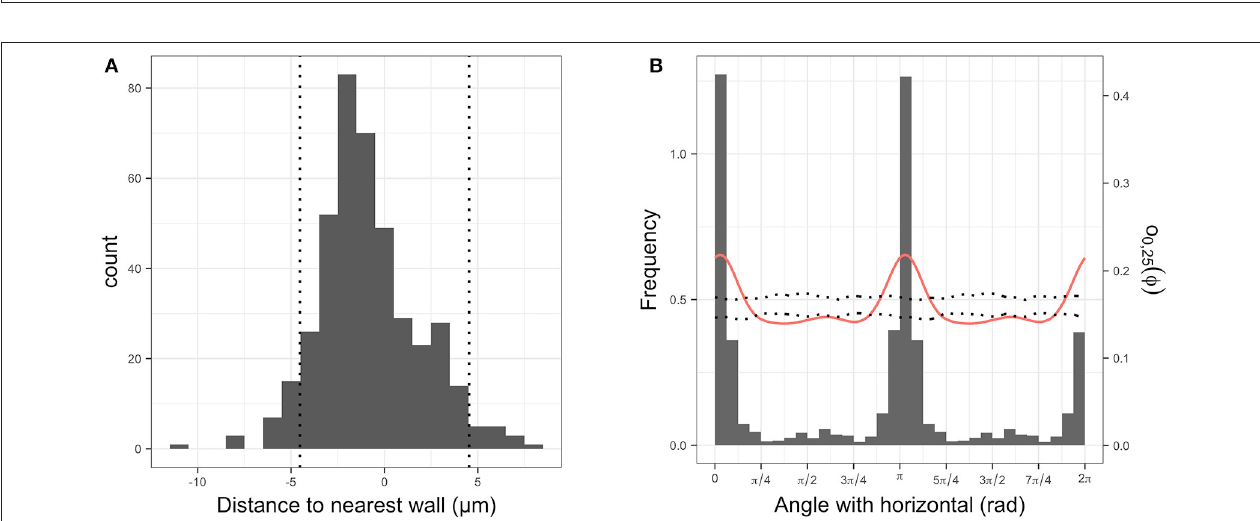
FIGURE 6 | (A) Histogram of signed distances between plant root cells and their nearest cell wall. The two vertical dotted lines indicate the average distance between two parallel cell walls. (B) Histogram of angles between walls and horizontal (in gray), observed pair orientation function O 0,25 ( 8 ) for cells less than 25 µ m apart (i.e., distribution of angles between two cells and the horizontal; red line) and envelope of the pair orientation function for 99 simulation of complete spatial randomness point